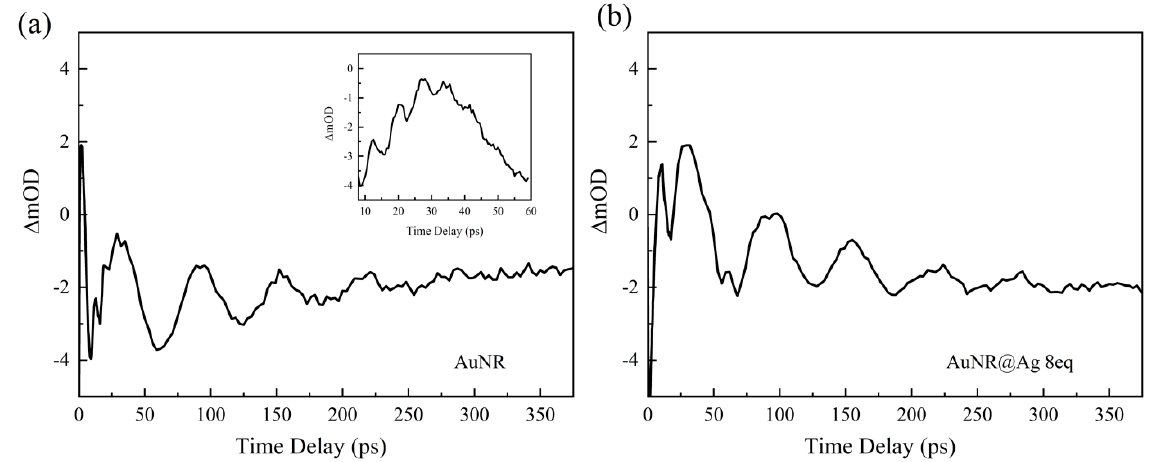
Figure 1. Transient signals of ( a ) AuNRs and ( b ) AuNR@Ag 8eq probed at the LgSPR domain (699 nm and 526 nm, respectively) upon photoexcitation at 380 nm. The inset of panel ( a ) reports the first 60 ps of the same profile acquired with shorter temporal step size.